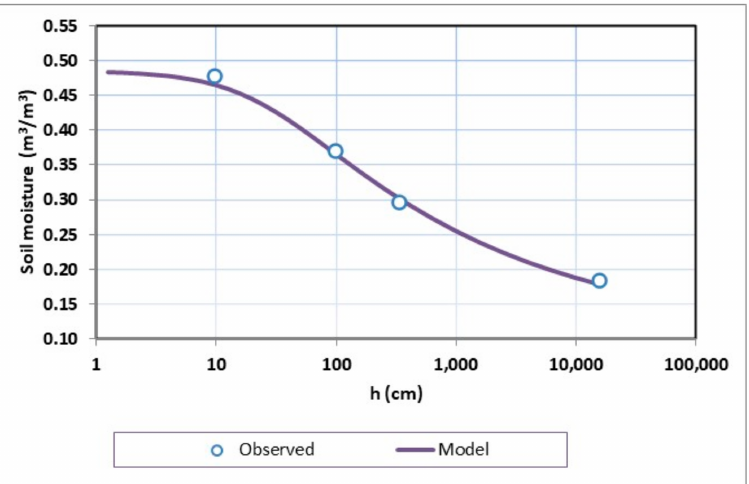
Figure 1. Water retention curve for the type of soil at the study